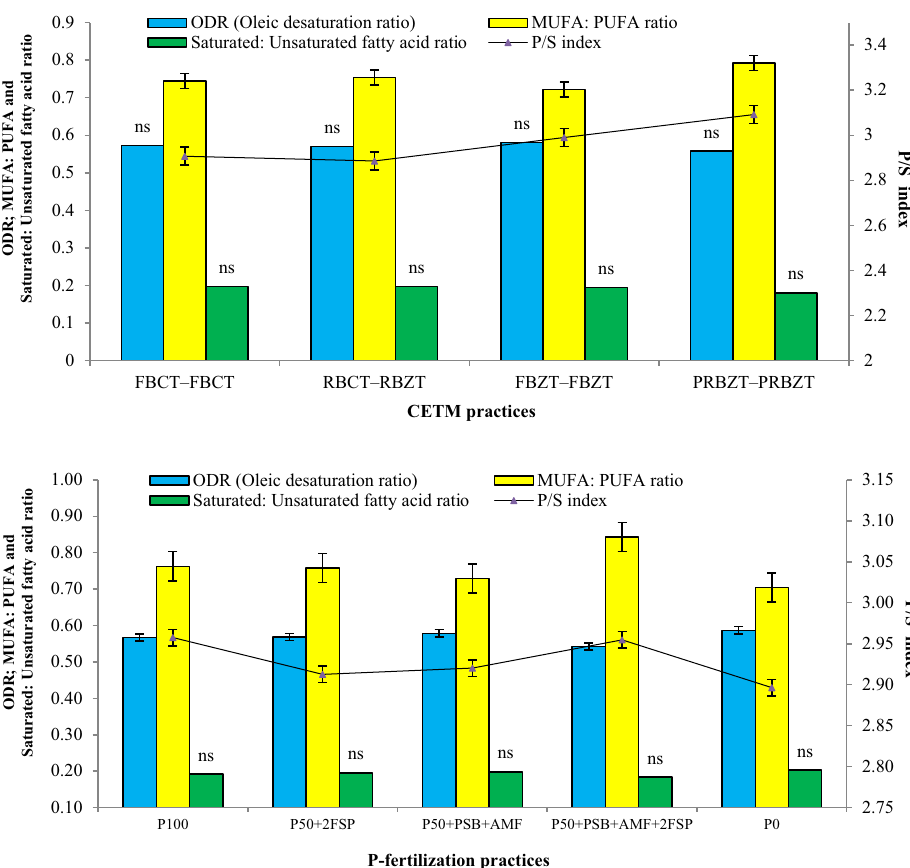
Figure 4. Influence of CETM and P-fertilization practices on various fatty acid ratios of maize under MWCS. The vertical bars represent LSD 0.05